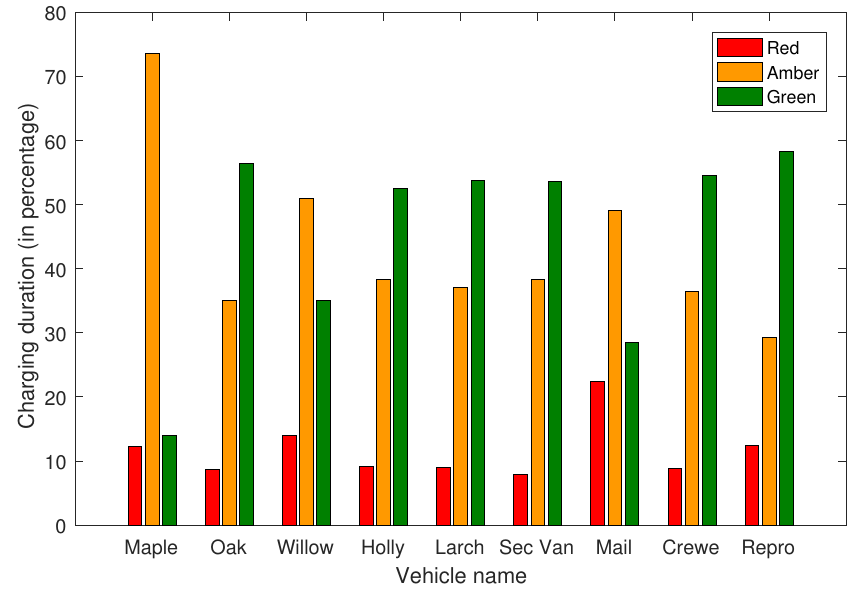
Figure 4. PEV charging by